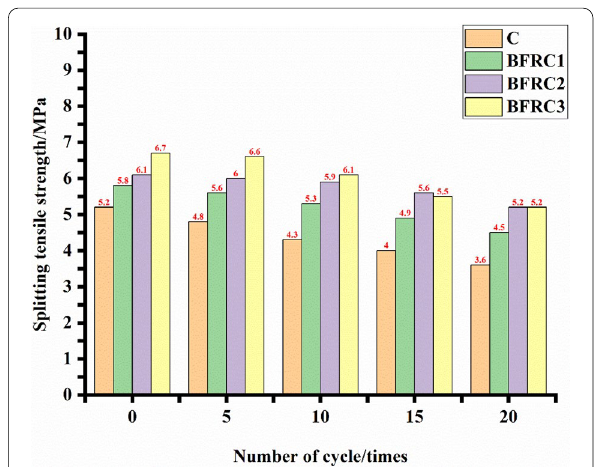
Fig. 7 The splitting tensile strength at different single-side salt-freezing–drying–wetting cycles.